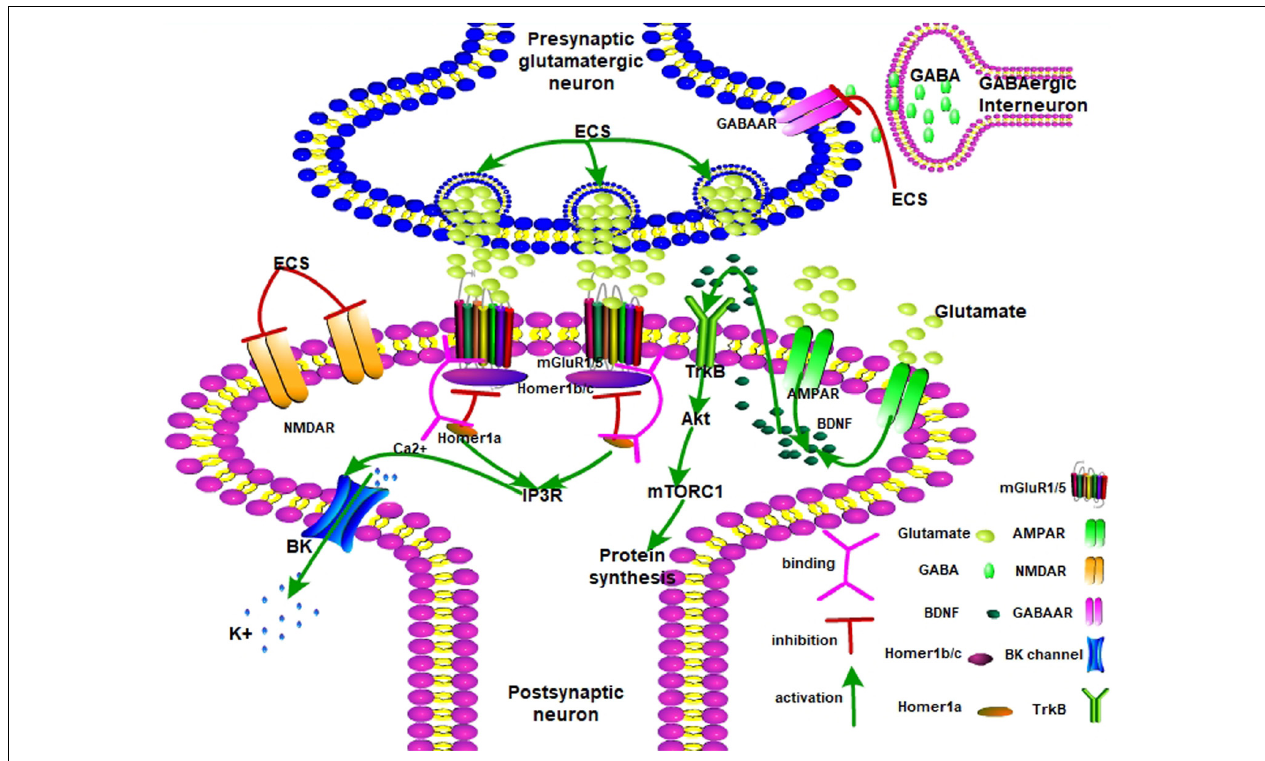
FIGURE 1 | The possible antidepressant mechanisms of ECS on depression. AMPA receptor, α -amino-3-hydroxy-5-methyl-4-isoxazolepropionic acid receptor; mGlu1/5 receptor, metabotropic glutamate receptor 1/5; mTORC1, mammalian target of rapamycin complex 1; NMDAR, N-methyl-D-aspartate receptor; GABAAR, gamma-aminobutyric acid type A receptor; TrkB, tropomyosin receptor kinase B; Akt, protein kinase B; mTORC1, mammalian target of rapamycin complex 1; IP3R, inositol 1,4,5-trisphosphate receptor; BDNF, brain-derived neurotrophic